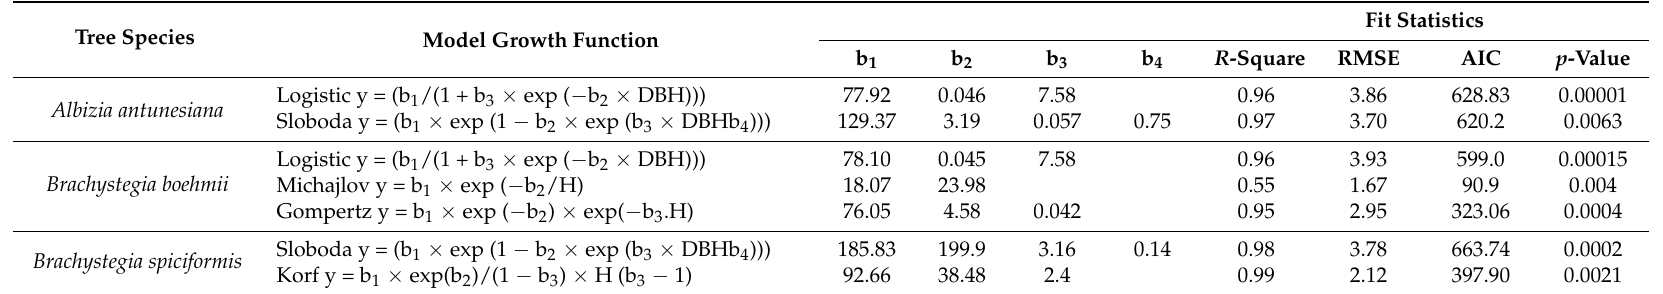
Table 5. Fitted statistics parameters for miombo tree